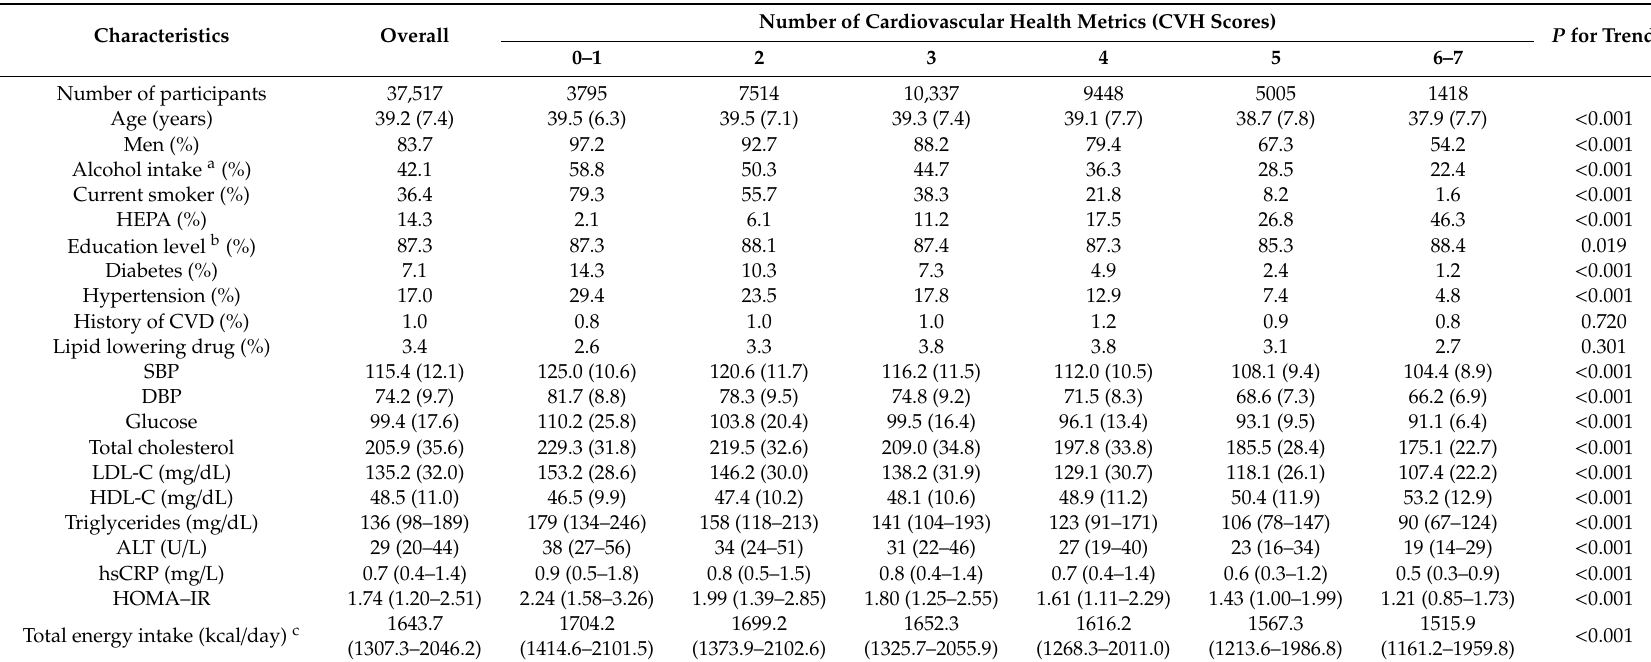
Table A1. Baseline characteristics by cardiovascular health metrics among 37,517 participants with nonalcoholic fatty liver disease (NAFLD).